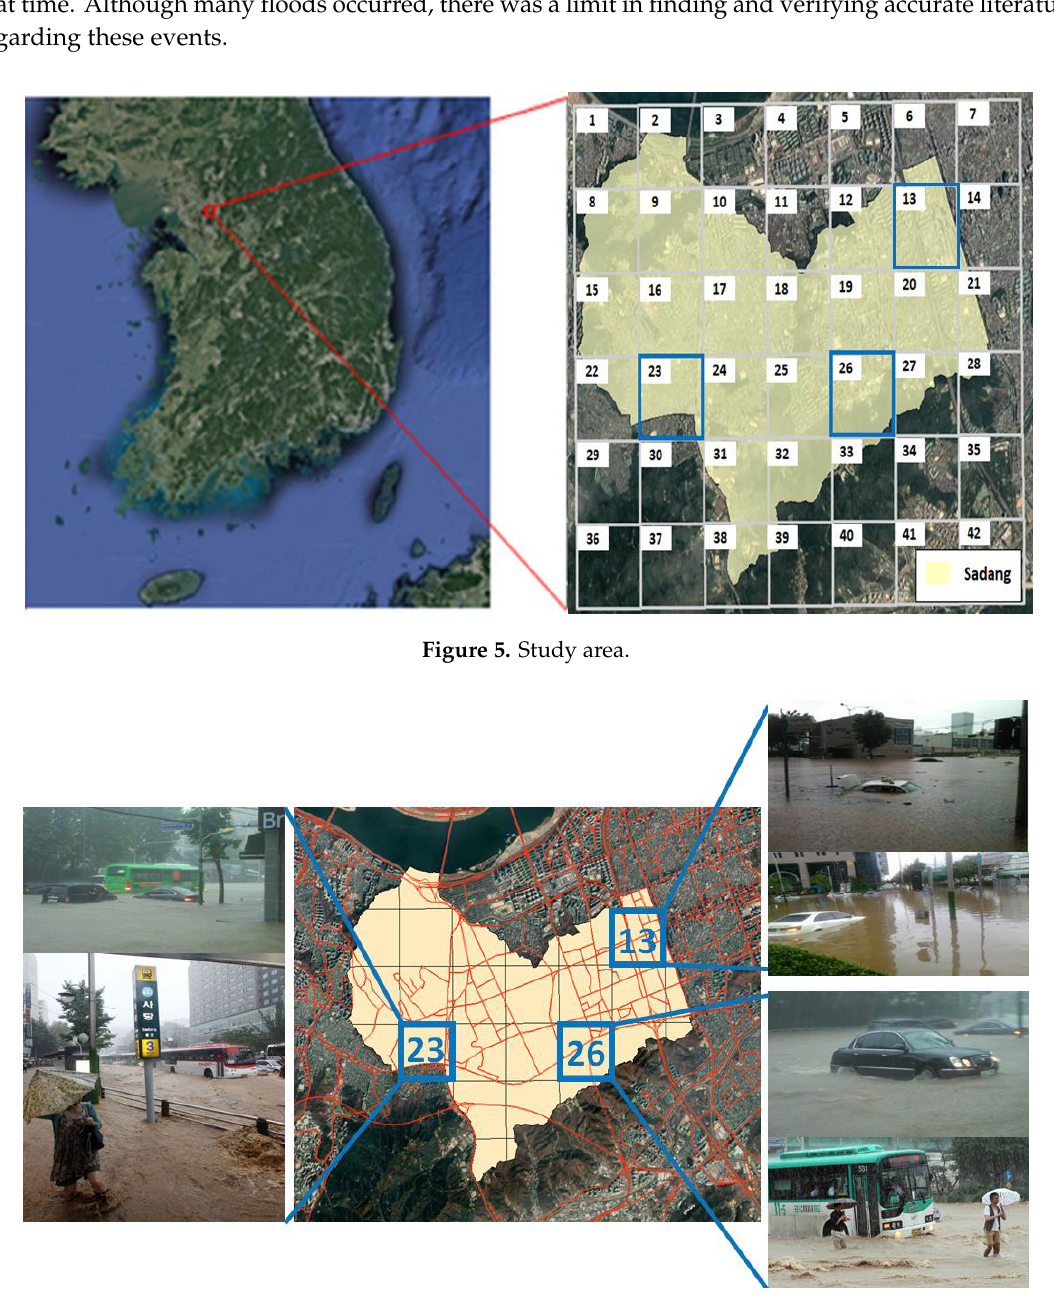
Figure 6. Photographs of actual damage to Sadang-dong area.